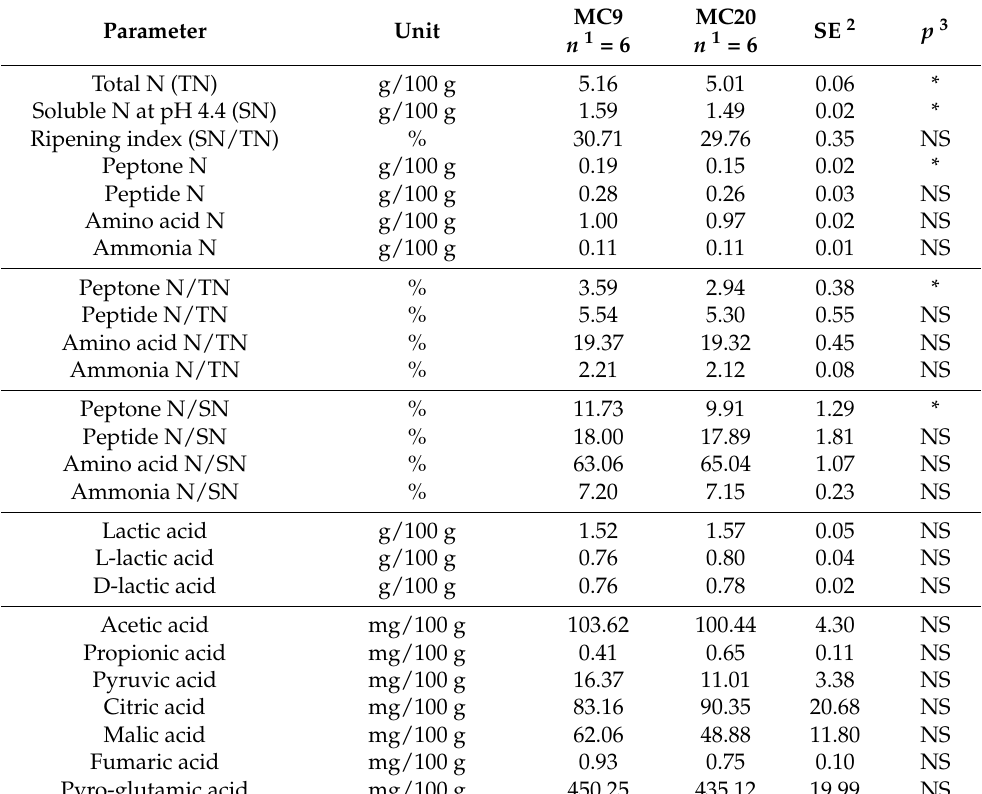
Table 4. Proteolysis and organic acid contents in the outer zone of cheese wheels produced by milk kept at the farm at 9 ◦ C (MC9) or 20 ◦ C (MC20) (least-square-mean values). Parameter